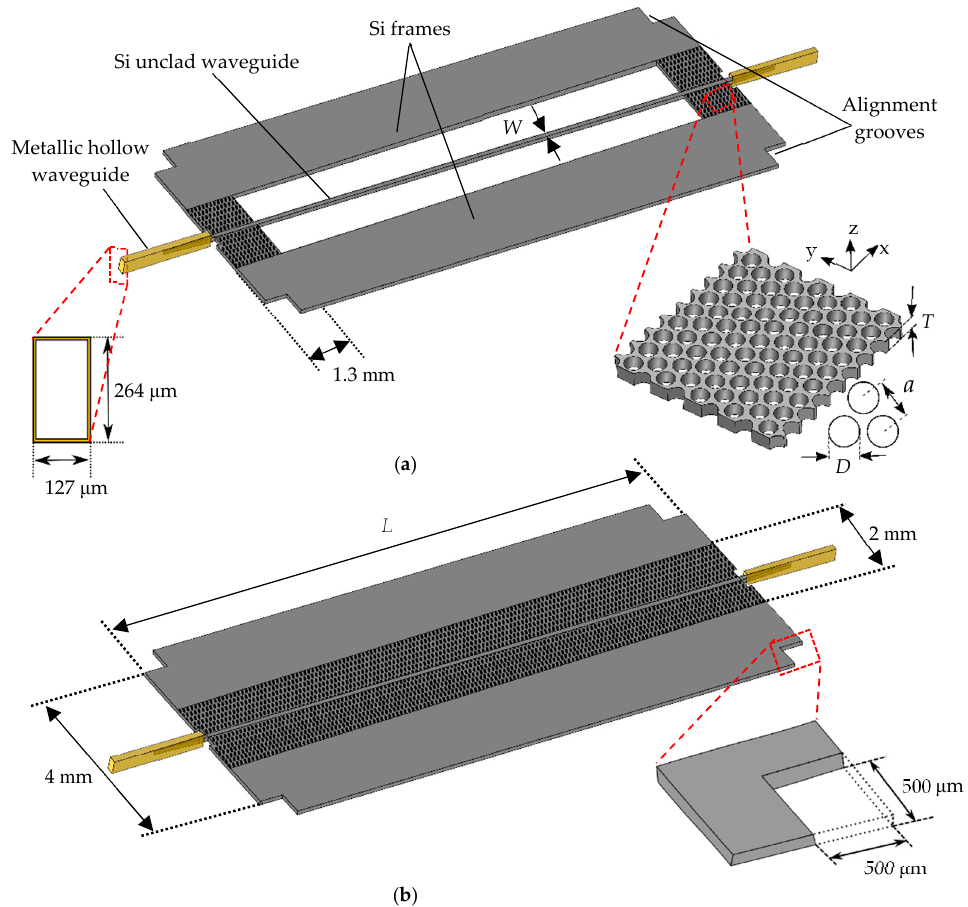
Figure 1. Designs of proposed dielectric waveguides: ( a ) Unclad waveguide; ( b ) EM waveguide; W = 100 µ m, D = 35 µ m, a = 45 µ m and T = 80 µ m.